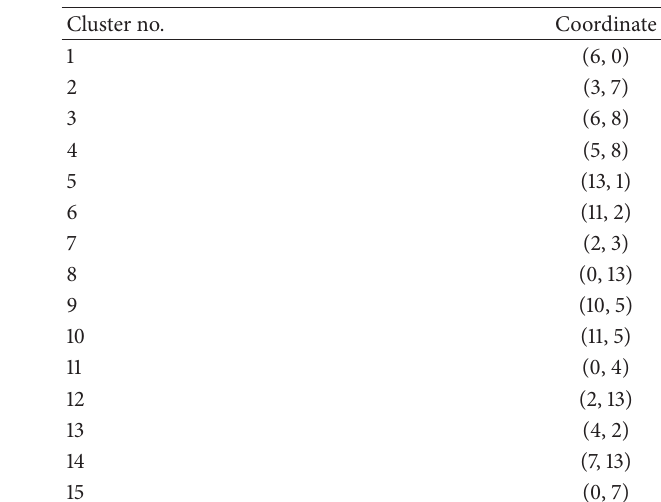
Figure 4: Comparison of the subgraphs’ distance when 𝑘 > 15 .